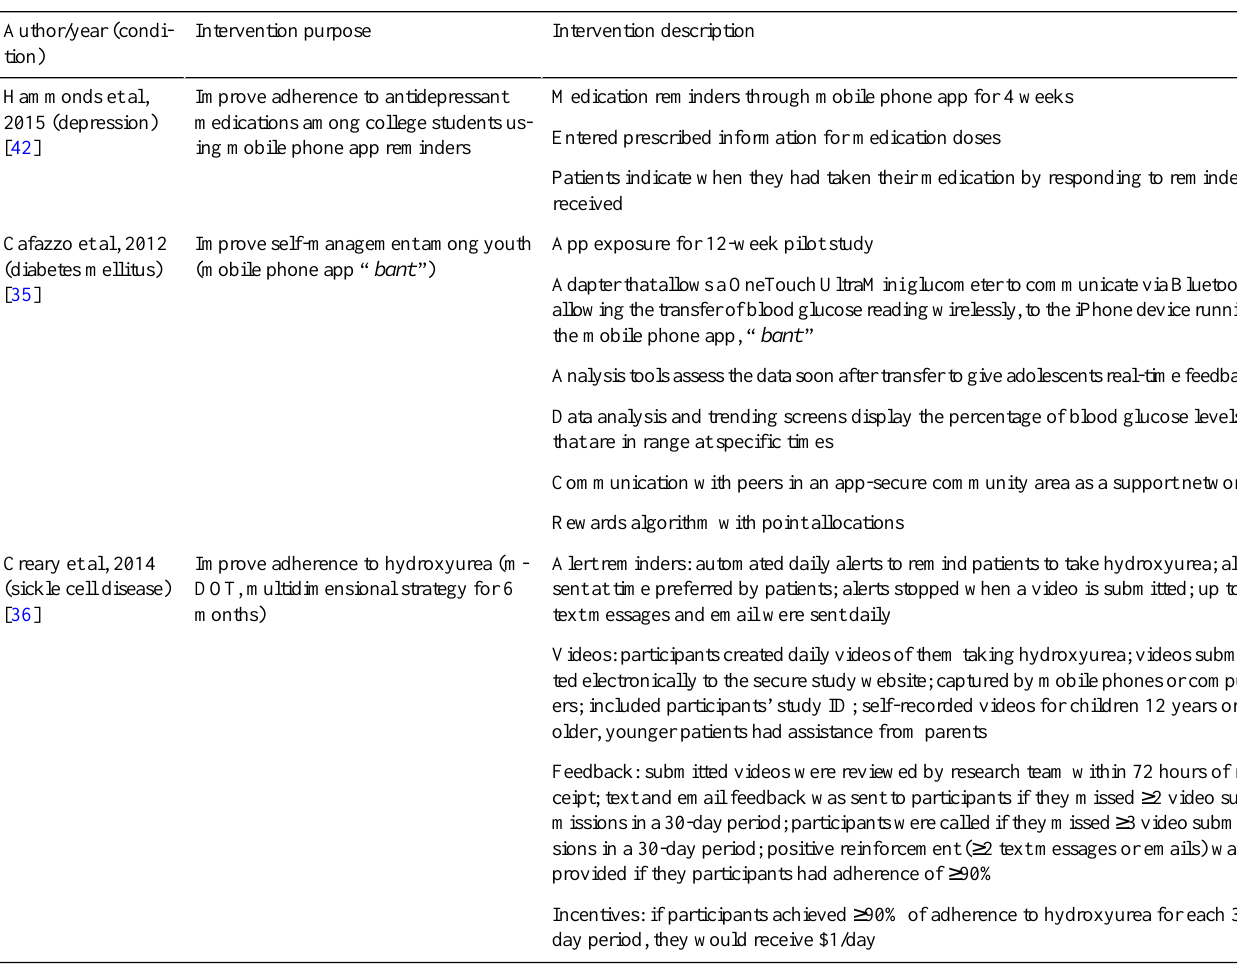
Table 3. Description of mobile phone app interventions.